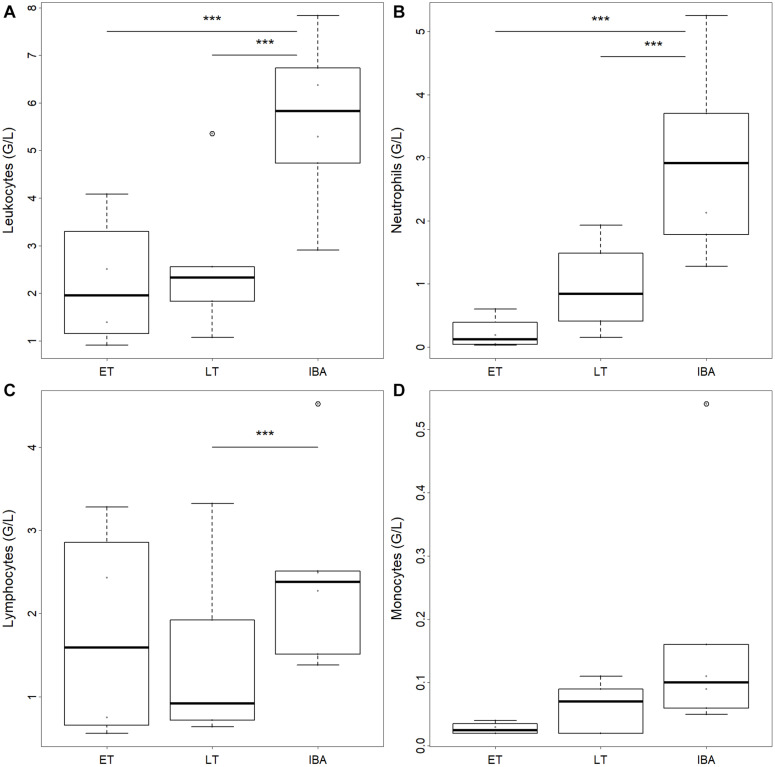
Box plots of circulating (A) total leukocyte, (B) neutrophil, (C) lymphocyte, and (D) monocyte numbers in hibernating garden dormice under different physiological states within the torpor-arousal cycle. Hibernating states correspond to early torpor (“ET,” n = 8), late-torpor (“LT,” n = 9), and interbout arousal (“IBA,” n = 8). Asterisks indicate significant differences between states (Post hoc Tukey-like test: ***p < 0.001). When not indicated, effects were non-significant.